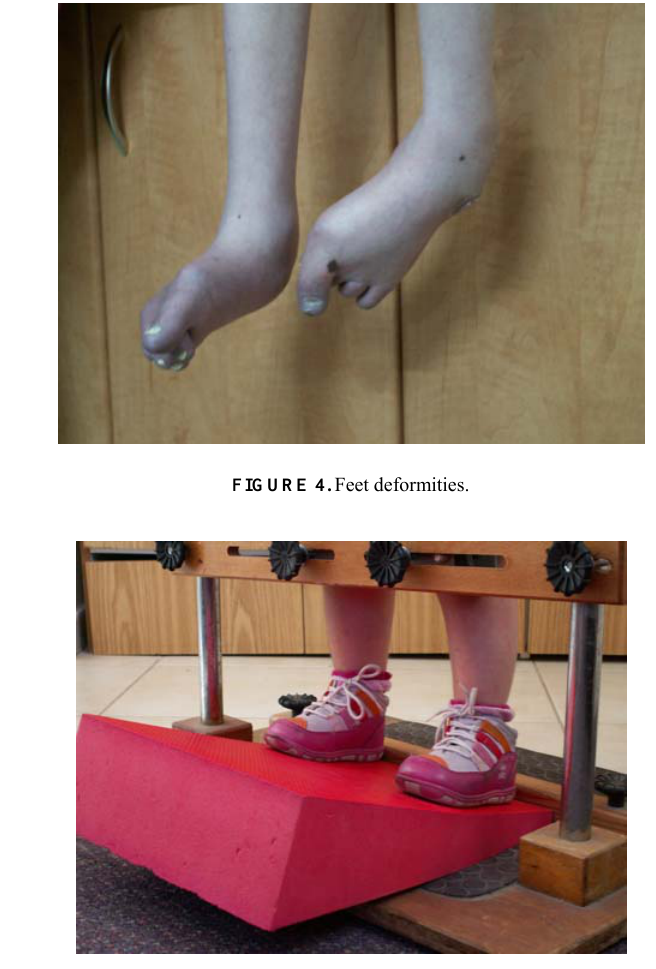
FIGURE 5. Stretching the gastrocnemius muscle while